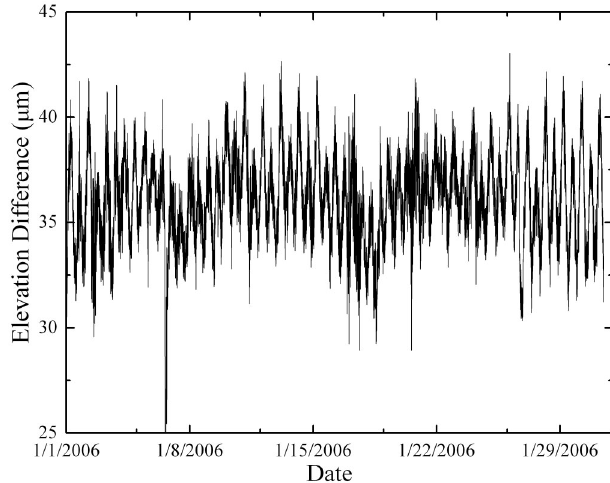
FIG. 39. January 2006 record of elevation difference for two HLS probes 90 m apart in the FNAL MINOS hall [30].